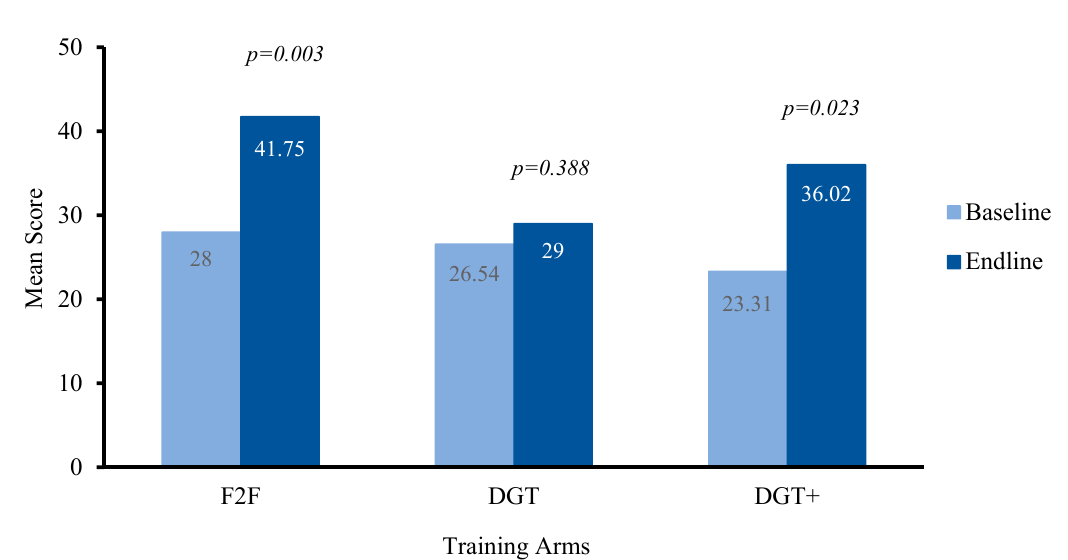
Figure 2. Change in competency assessment scores within each training program. Note: this Figure includes scores from the n = 11 in F2F, n = 12 in DGT, and n = 13 DGT+ participants who completed the post-training (endline) competency measure; though, some of these participants did not complete the training programs. F2F: Face-to-Face; DGT: Digital Training.